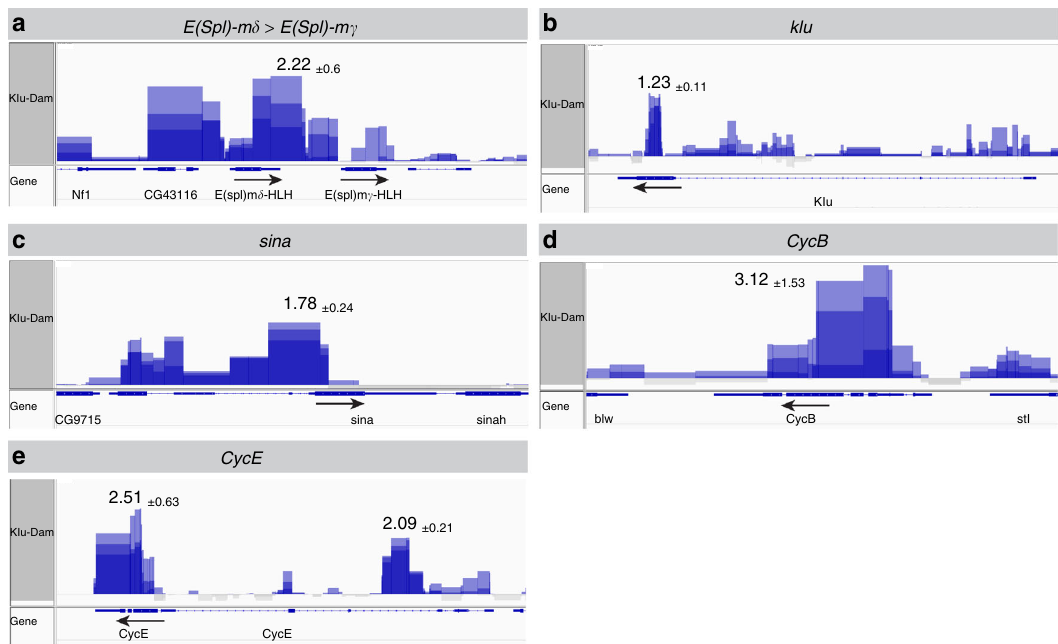
Fig. 7 Klu binds genes involved in Notch, cell cycle, and EE fate. a – e Klu-Dam binding tracks (in triplicate) for the E(Spl)- complex locus ( a ), klu ( b ), sina ( c ), and the Cyclins CycB ( d ) and CycE ( e ). Tracks are displayed in Integrated Genome Viewer (IGV) as overlayed tracks of the triplicate Klu-Dam vs Dam-only control comparisons. Arrows indicate direction of transcription. Numbers indicate average maximum peak height (log 2 FC of Klu-Dam over Dam-only control ± SD) for each of the three E3-ligase complex Sina, Sinah, and (indirectly) Phyl that can normally target Ttk for destruction.